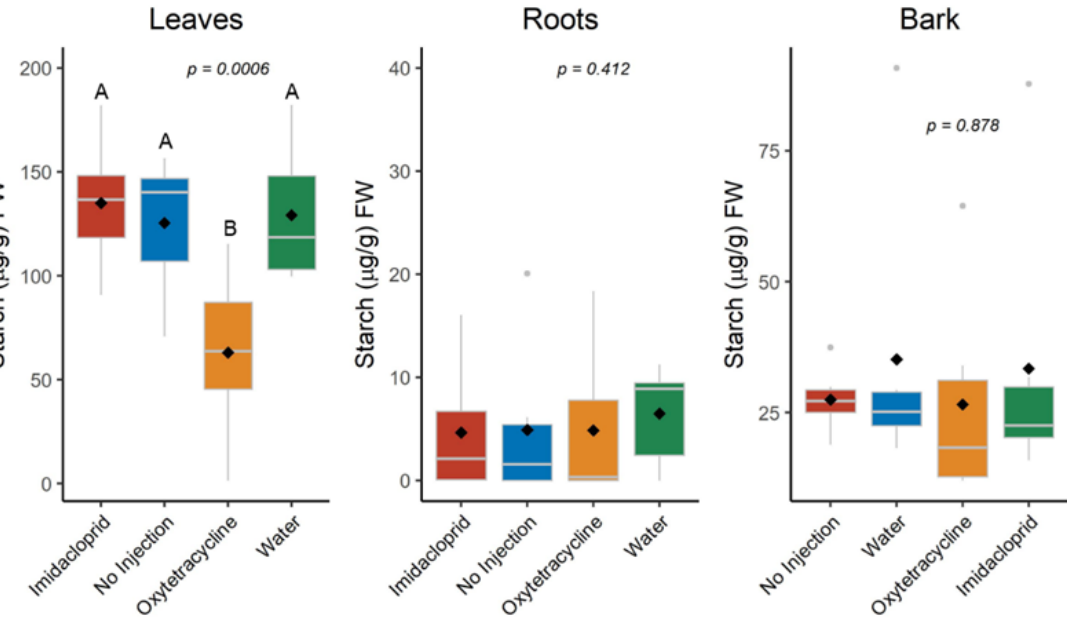
Figure 8. Starch content in February 2022 of root, leaf, and bark tissue from trees injected in October 2020 and April 2021. Different letters indicate significant differences ( p < 0.05) according to Tukey’s honest significant difference test. Letters not shown where differences were not significant.